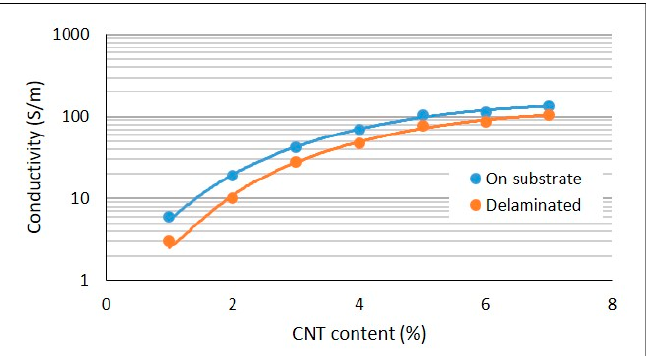
Figure 3. Electrical conductivity of silicone/CNT composites in relation to filler content. The blue curve represents the electrical conductivity of the composites that were sup- ported by substrate, while the orange curve represents the electrical conductivity of the composites that were delaminated from the substrate. As expected, the electrical conduc- tivity of the composites increased with CNT loading. As the CNTs were added to the sil- icone matrix, at a loading of 1%, the CNT aggregates came into contact with each other, forming a continuous conductive network, allowing electron flow throughout the sample.